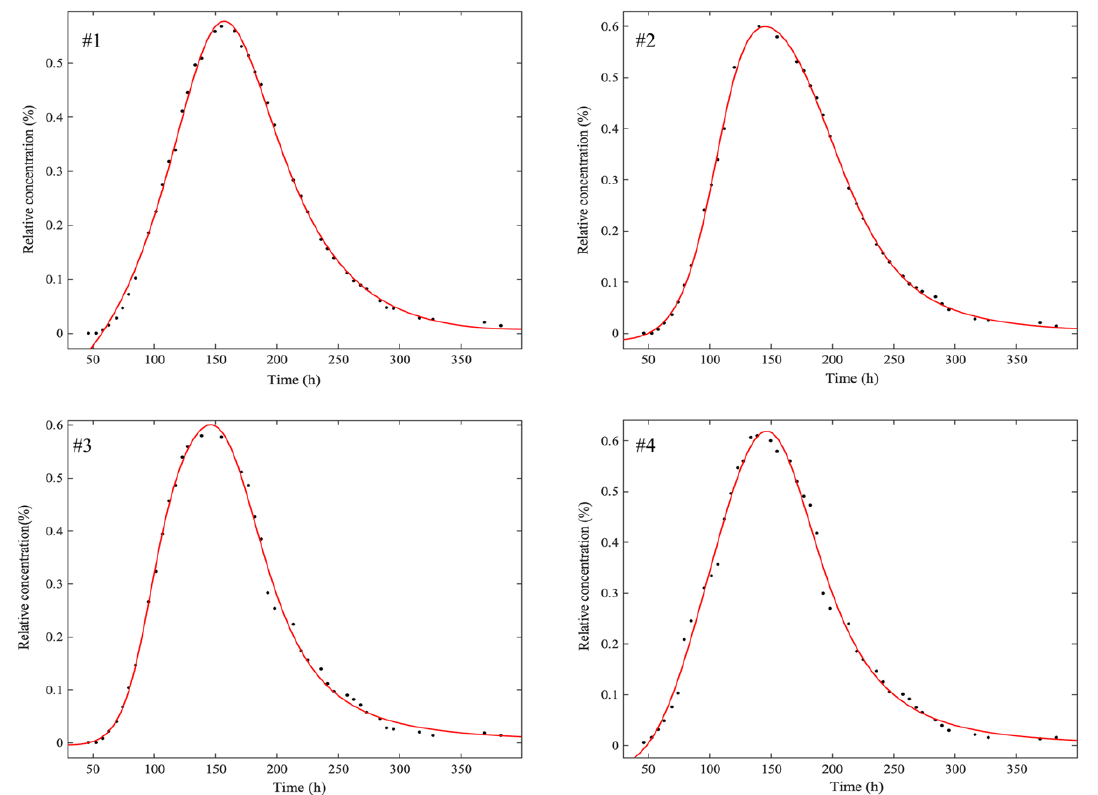
Figure 5. BTCs obtained using ERT data for 4 sites. (The black dot represents the measured data and the red line represents the fitting curve)